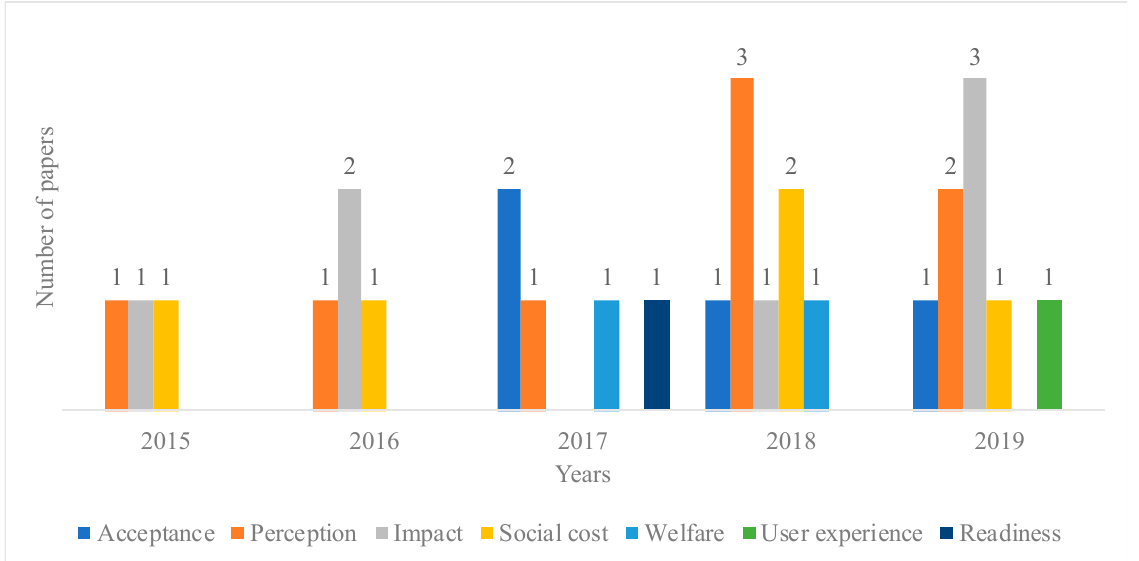
Figure 3. The research focus of papers related to social aspects of EVs included in Web of Science ( WoS) in the last five years.